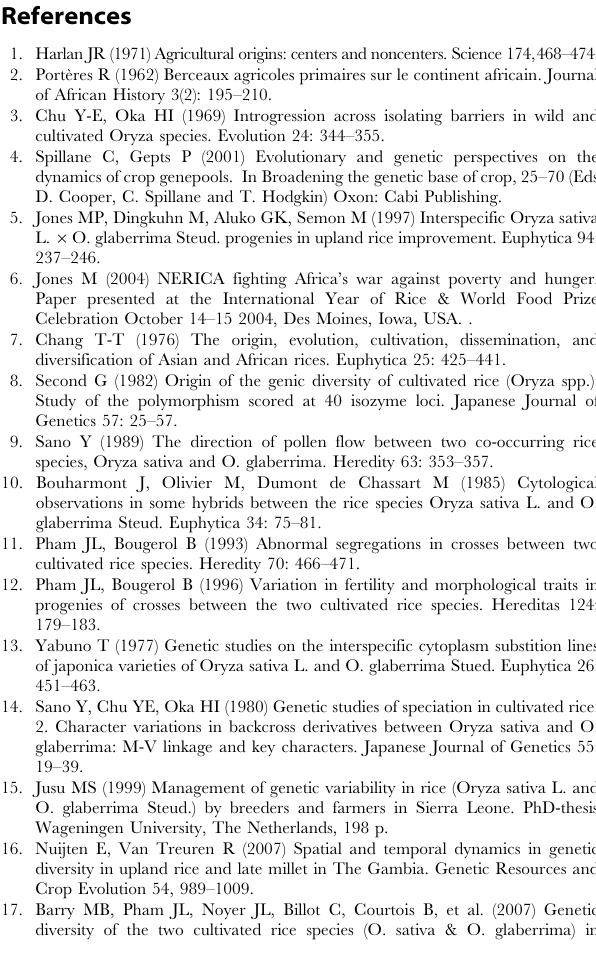
Table S1 Overview of the 315 investigated rice samples and their assignment to the four observed clusters by the software